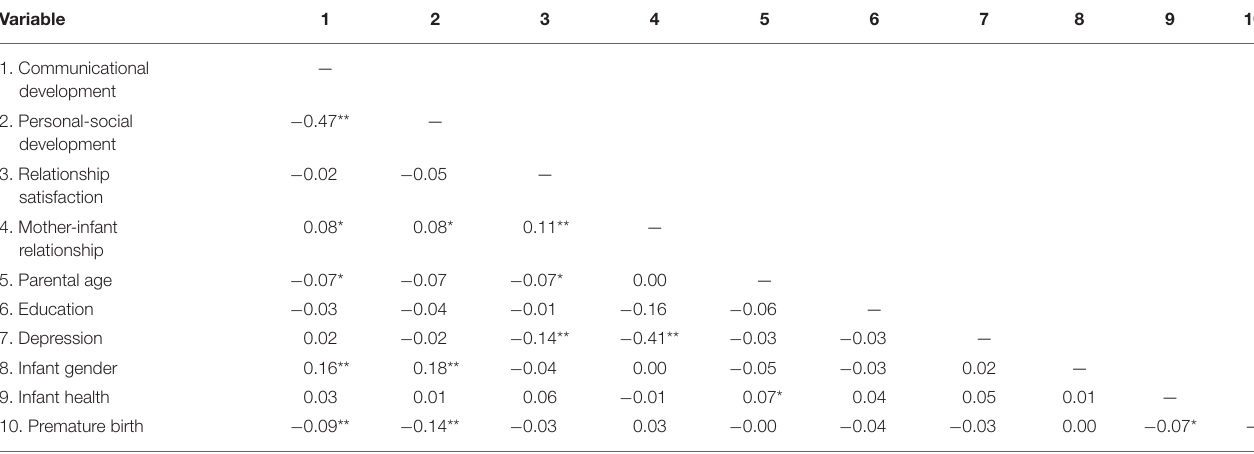
TABLE 2 | Pearson correlation coefficients ( r ) of predictors, control variables, and outcomes for mothers. Variable